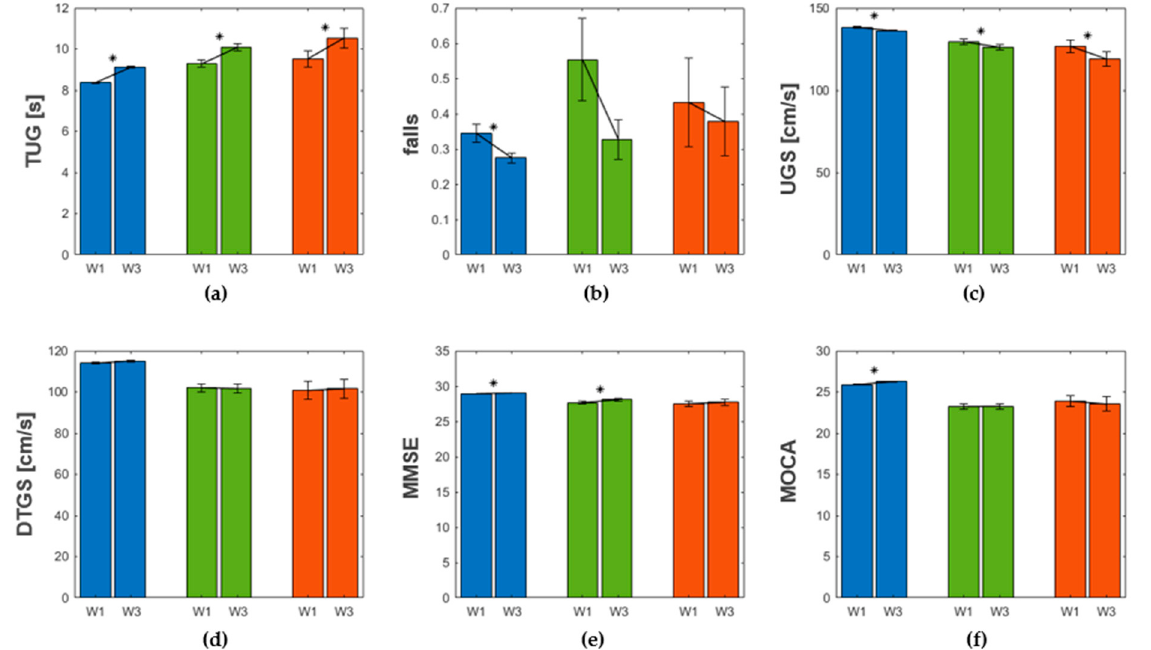
Figure 8. Evolution of TUG ( a ), number of falls reported ( b) , UGS ( c ), DTGS ( d ), MMSE ( e ) and MOCA ( f ) from wave 1 to wave 3 specific for each cluster. The bars are coloured based on the corresponding cluster (blue, green and red, respectively). The height of the bars indicates the average value of the variable for a given cluster in a given wave. Stars indicate whether the difference of distributions of values of a given variable for a given cluster was statistically significant between